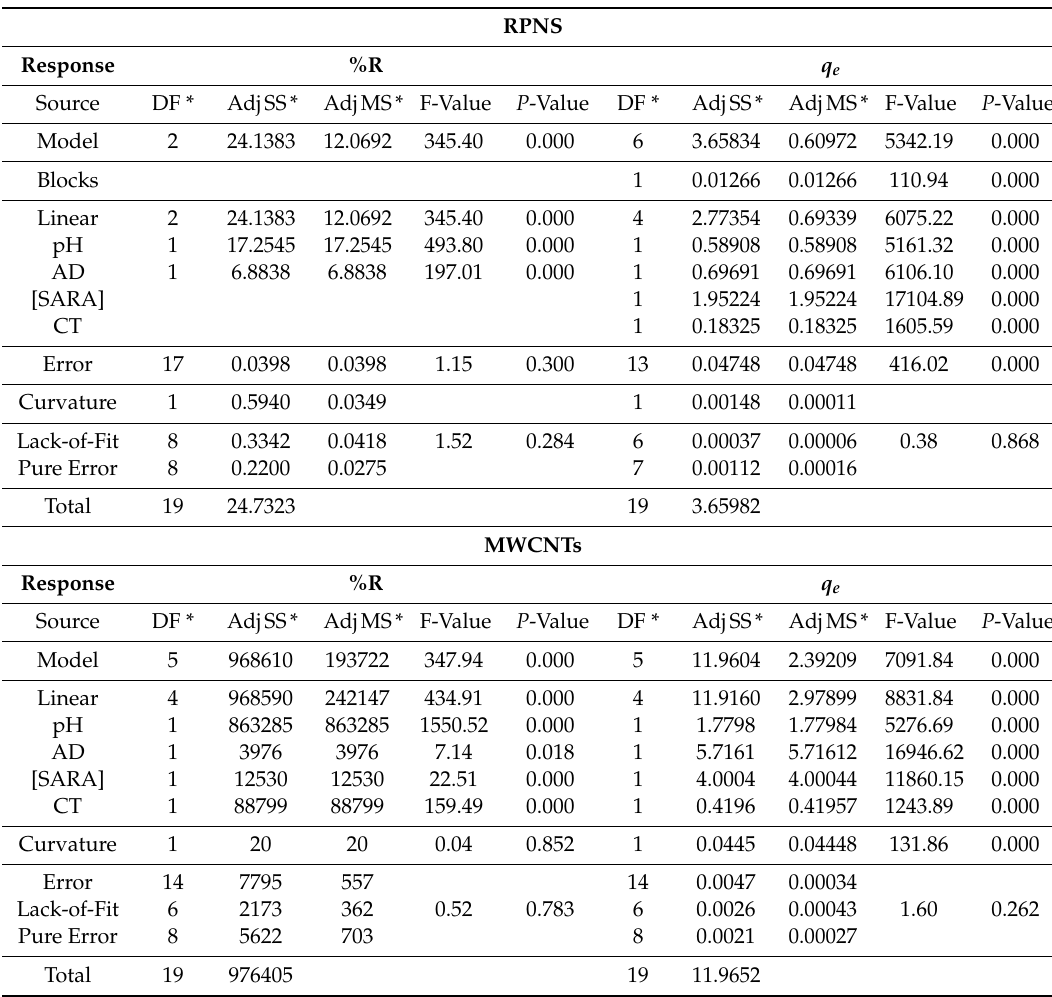
Table 5. Analysis of variance (ANOVA) for the transformed responses for both adsorbents.